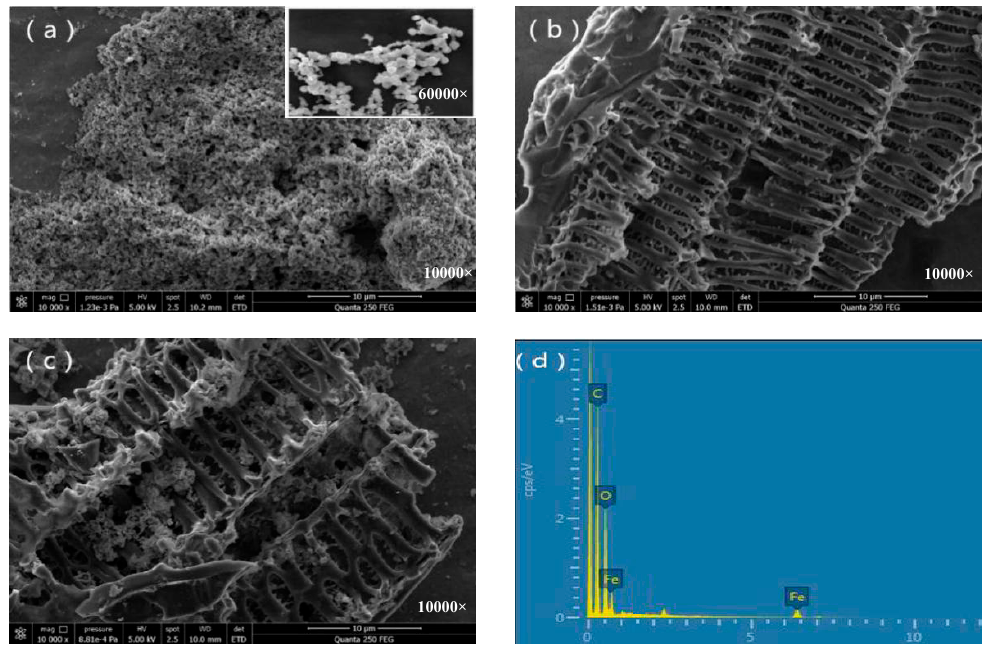
Figure 1. Scanning electron microscopy (SEM) images of nano zero-valent iron (nZVI) ( a ), peanut shell biochar (BC) ( b ), nZVI/peanut shell BC ( c ), and the EDS (Energy-disperse spectra) pattern of nZVI/peanut shell BC ( d ).